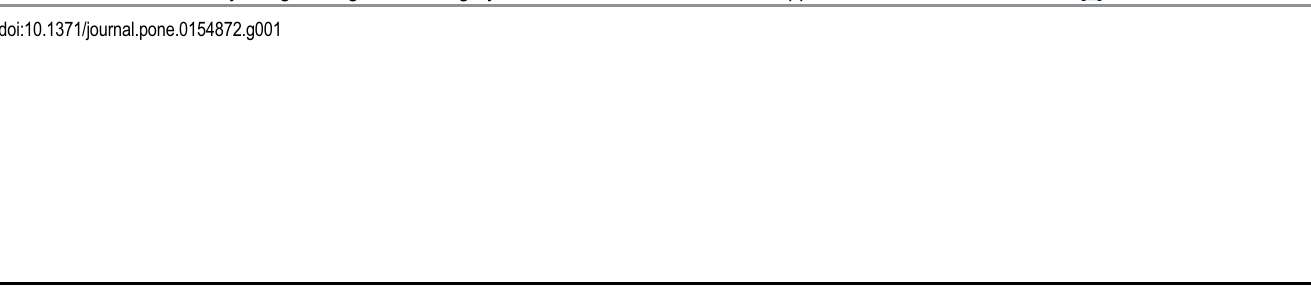
PLOS ONE | DOI:10.1371/journal.pone.0154872 May 5, 2016 3 /